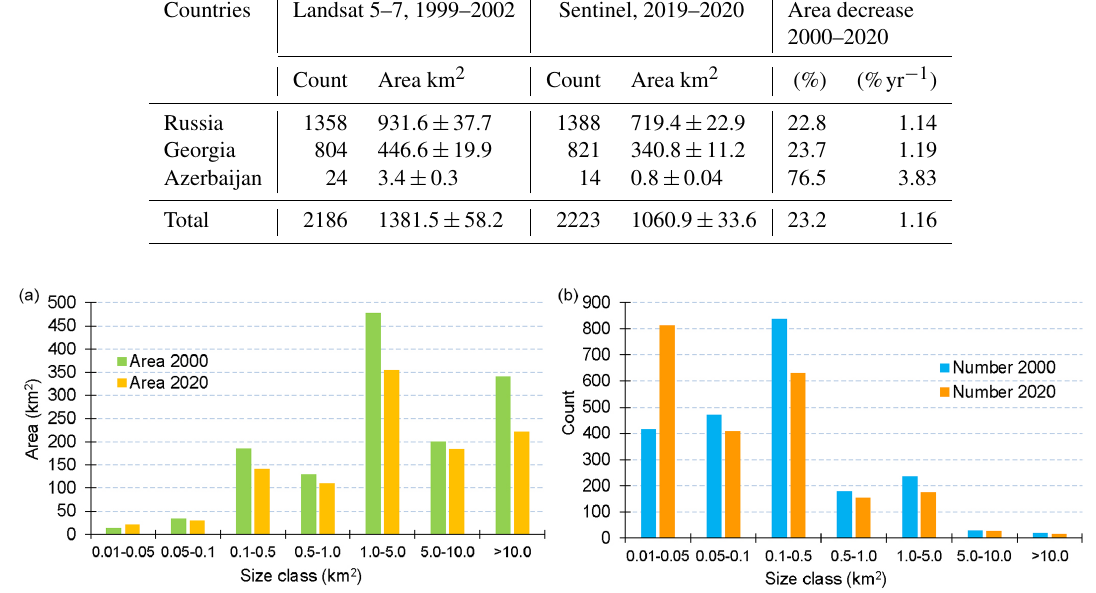
Table 1. The Greater Caucasus glacier count and area change in 2000–2020 by country. Countries